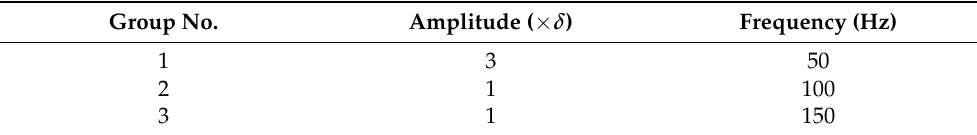
Table 2. Vibration condition setting.